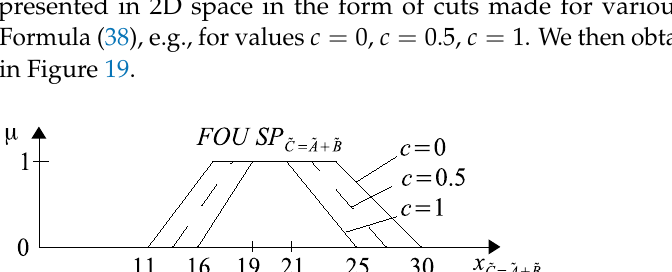
of the span function SP ˜ C = ˜ A + ˜ B